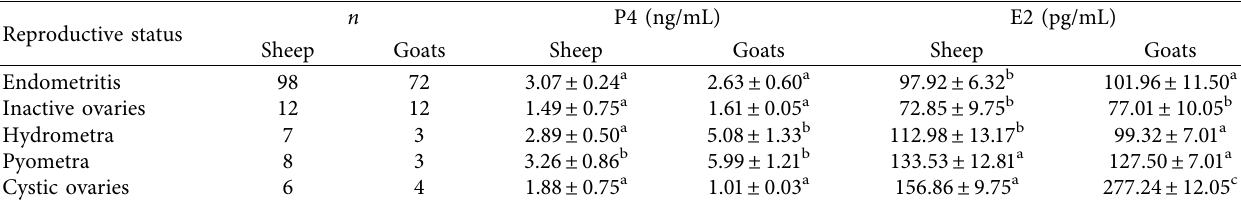
Table 3: Serum estrogen (E2) and progesterone (P4) associated with genital disorders in ewes and